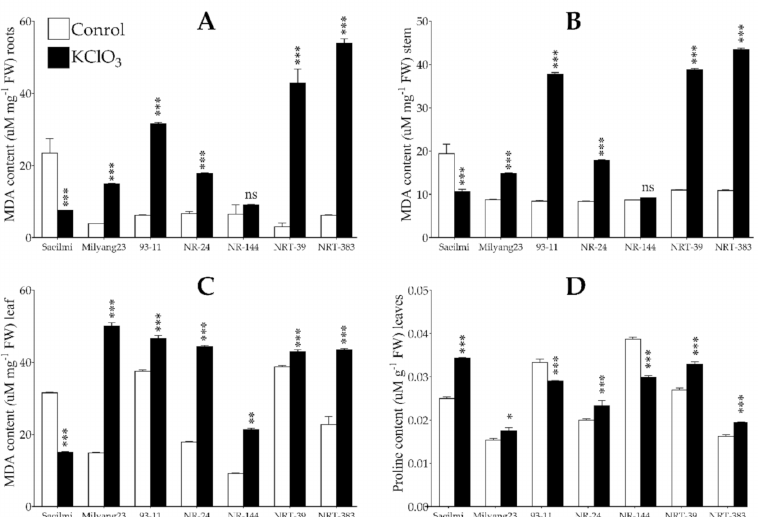
Figure 5. Lipid peroxidation and proline change in proline content. ( A ) Lipid peroxidation by malondialdehyde (MDA) content in the roots, ( B ) stem, and ( C ) leaf tissues in response to potassium chlorate (KClO 3 ) treatment, and ( D ) pattern of proline accumulation under KClO 3 treatment. Bars are mean values of triplicates ± SE. *** p < 0.001, ** p < 0.01, * p < 0.05, ns